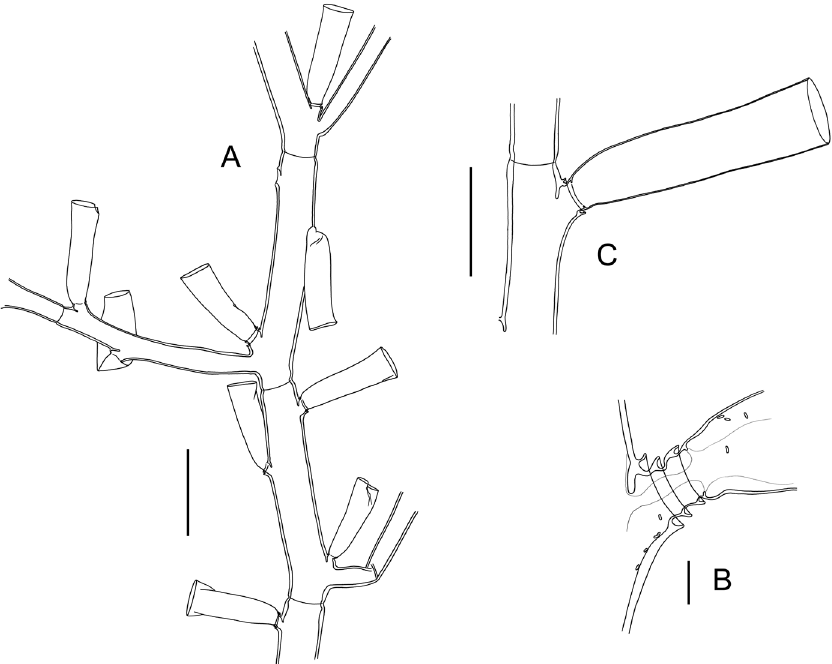
Fig. 5. Billardia hyalina Vervoort & Watson, 2003. A–C . Portion of stem with proximal parts of three consecutive cladia (A), detail of stem apophysis for insertion of hydrotheca (B, note regenerations), hydrotheca (C), all from sample MNHN-IK-2015-474. Scale bars: A = 1 mm; B = 100 µm; C =